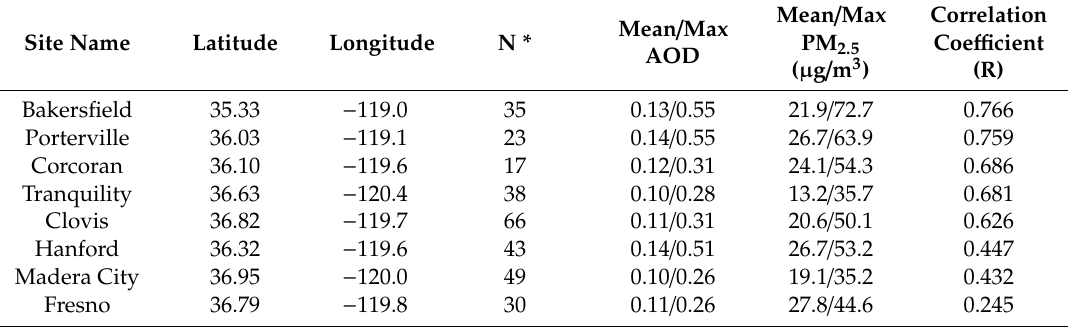
Figure 1. Aerosol Robotic Network (AERONET) sites (black circles) and co-located PM 2.5 sites (red circles) during the Distributed Regional Aerosol Gridded Observation Networks (DRAGON) campaign over Central Valley, CA, USA. Long-term Air Quality System (AQS) PM 2.5 sites (blue circles) have available data since 2002 onwards. Table 1. Summary statistics of AOD from DRAGON-AERONET sites co-located with PM 2.5 from EPA AQS monitors for the whole DRAGON campaign period 11 / 2012–4 / 2013. The correlation coe ffi cient is between AOD and PM2.5, per